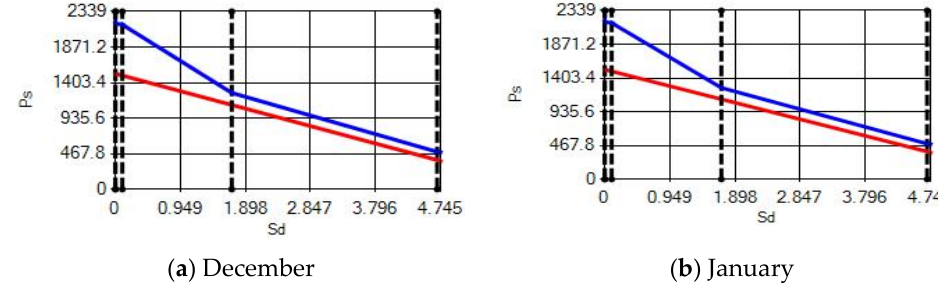
Figure 17. Condensation and evaporation amount chart for the building elements of the AAC external wall for the 4th zone for ( a ) December and ( b ) January.